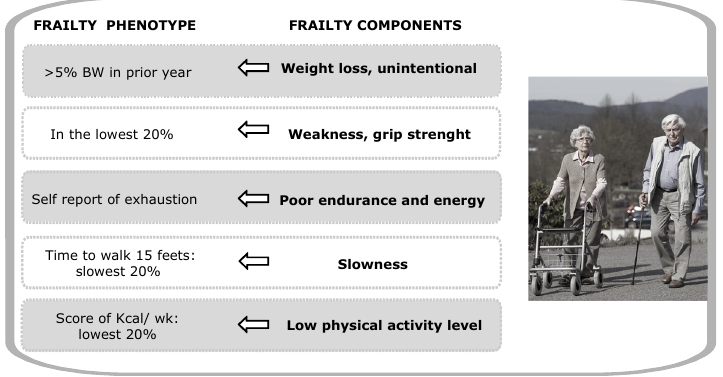
Figure 1. Frailty features contributing to the frailty phenotype during aging.